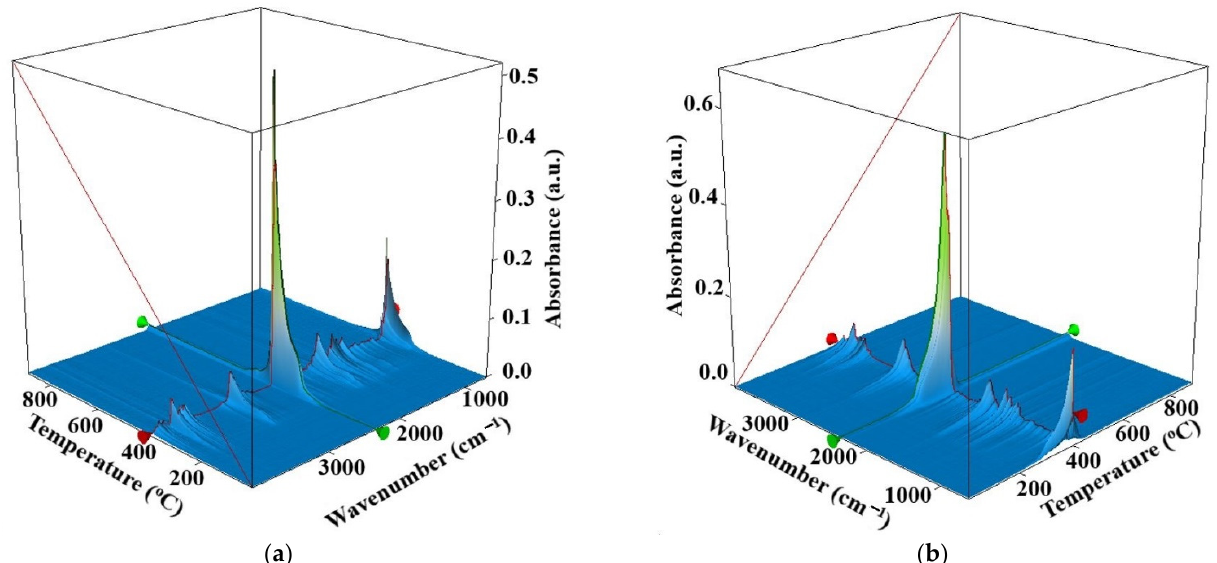
Figure 11. FTIR 3D chromatograms for evolved gases obtained for osmium nanoparticles-polypropylene hollow fiber composite membranes: Os-PP1 ( a ); and Os-PP2 ( b ). The 3D FTIR chromatograms for Os-PP1 (Figure 11a) and Os-PP2 (Figure 11b)